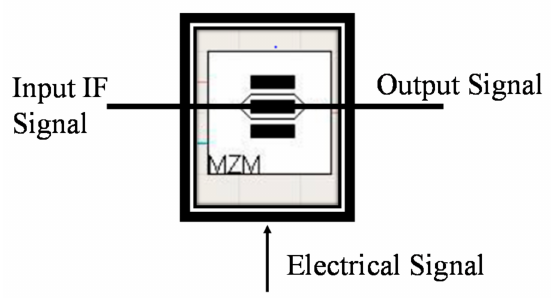
Figure 1. Schematic diagram of a Mach–Zehnder modulator.